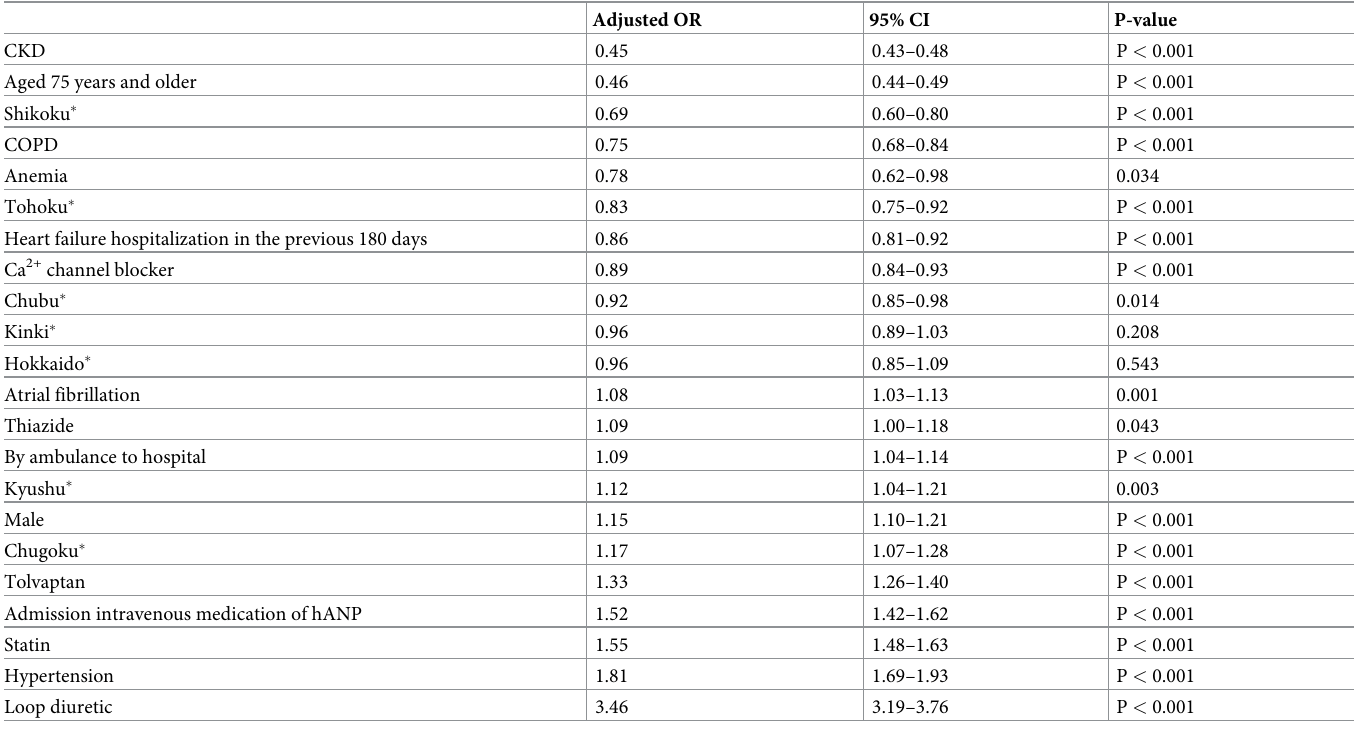
Table 3. Associations between patient characteristics and triple